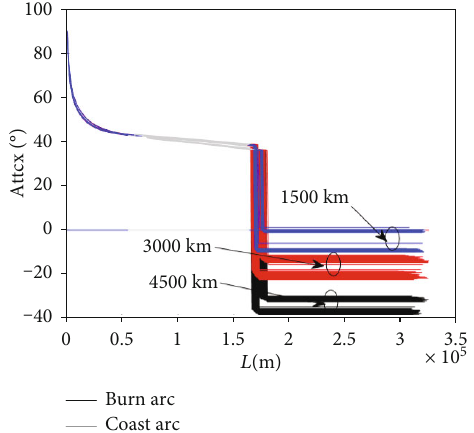
Figure 9: The guidance commands the history with deviation and uncertainty under di ff erent missions.